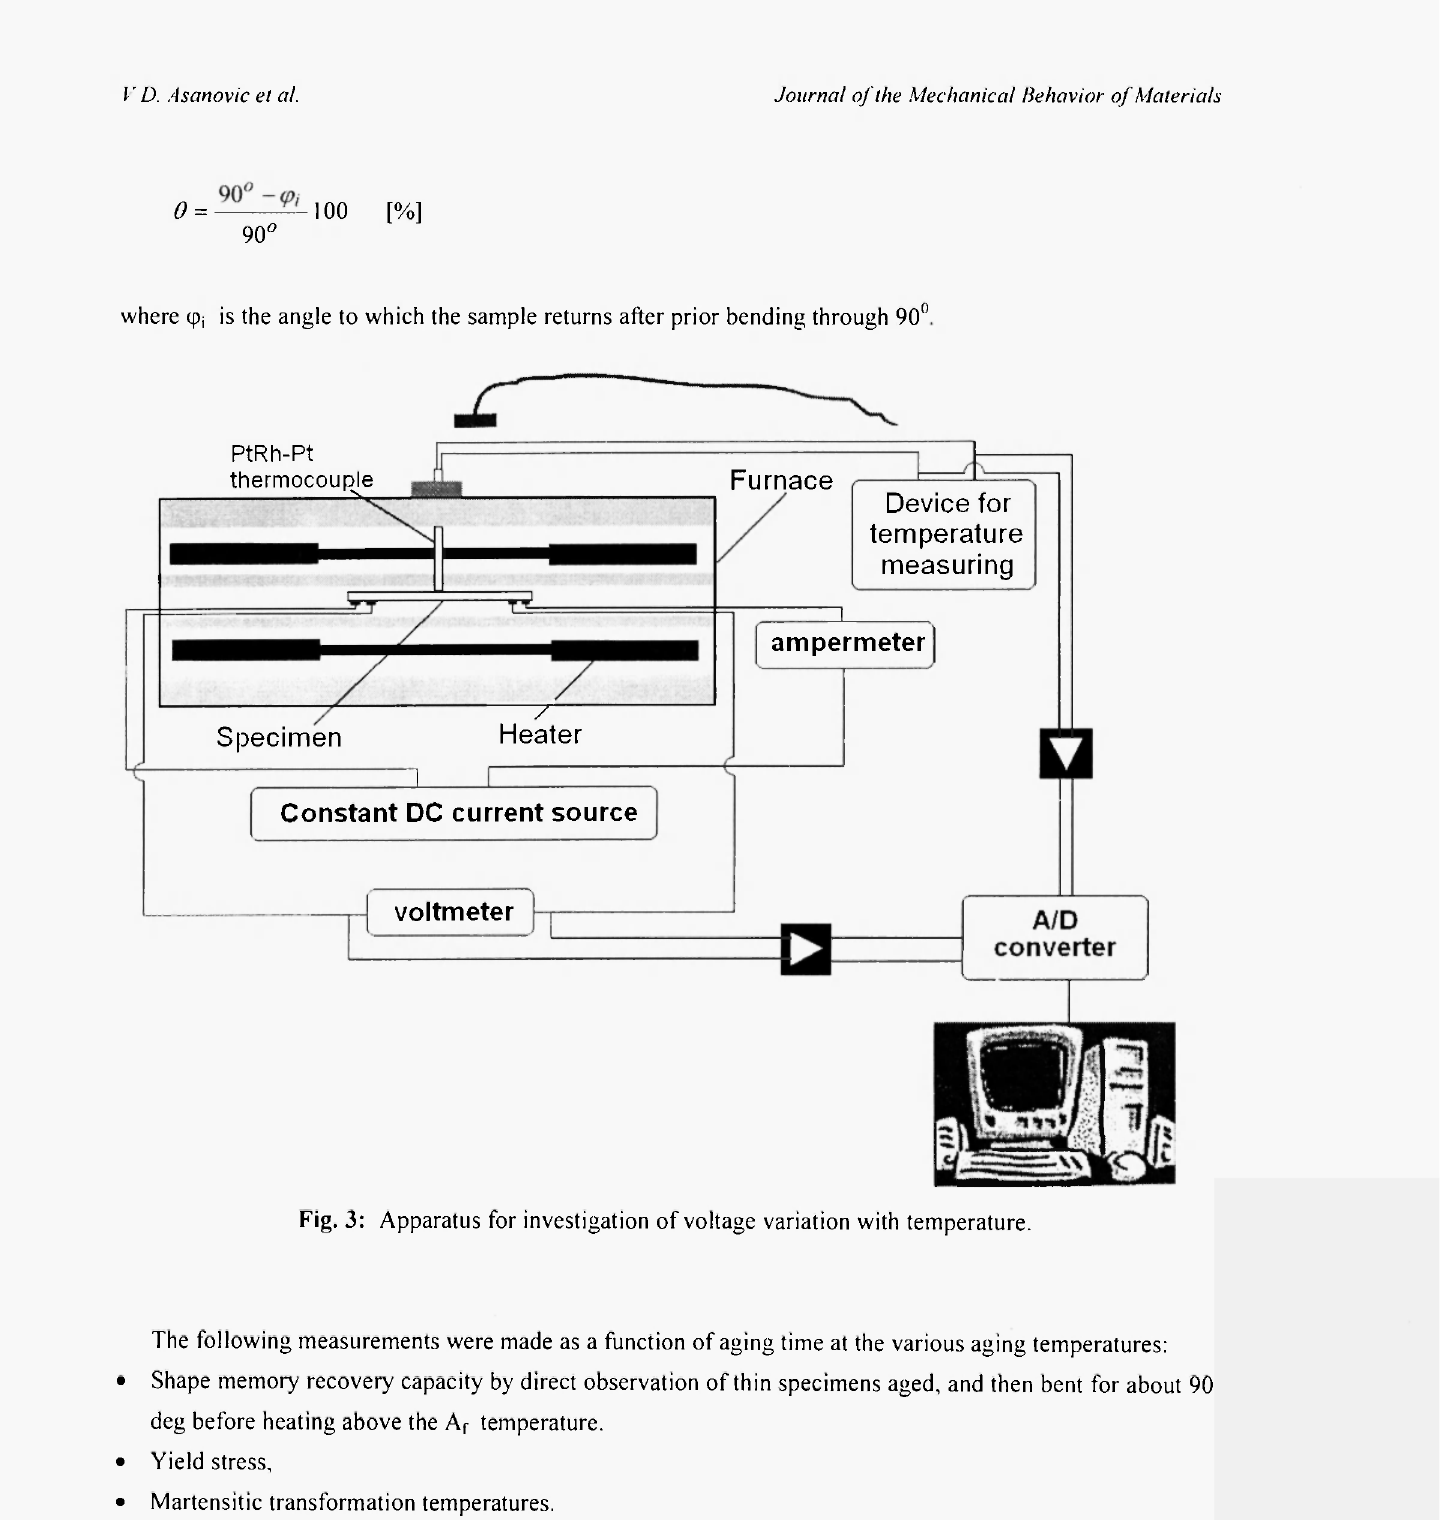
Fig. 3: Apparatus for investigation of voltage variation with